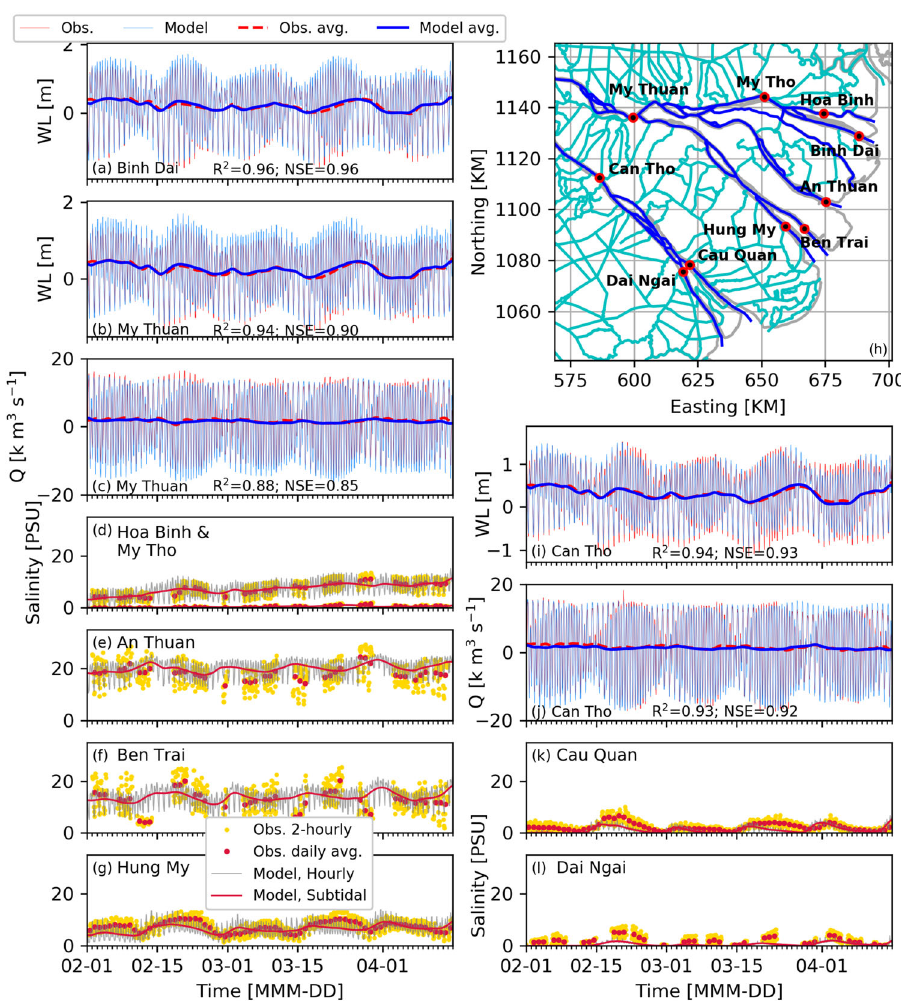
Fig. 6 Model validation agianst various gauge data. Model versus observed time series at measurement stations (locations in panel h) in Tien ( a - g ) and Hau Rivers ( i - l ) for water level (WL: a , b & i ), discharge (Q: c & j ) and salinity ( d - g , k , and l ) during the year